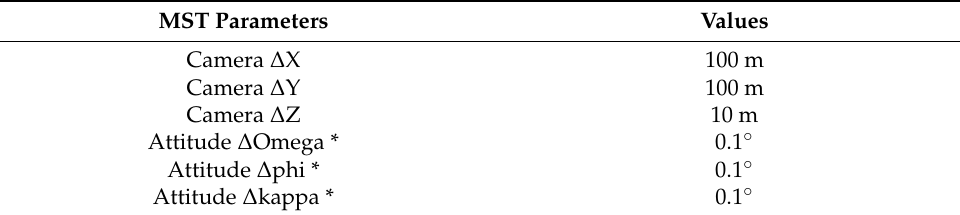
Table 2. A priori bundle adjustment